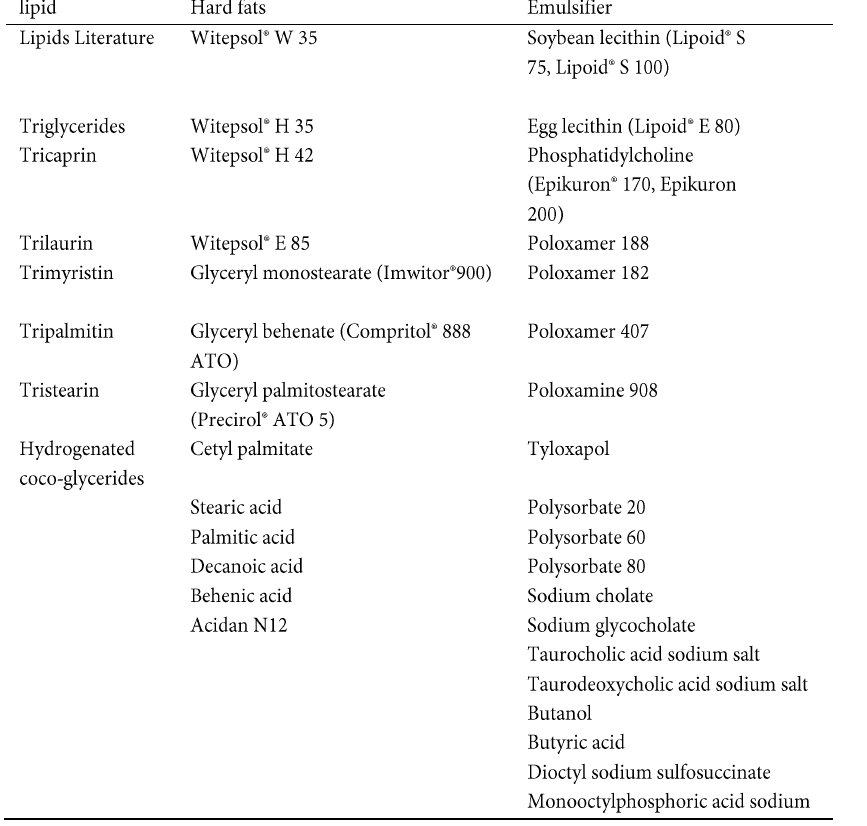
Table 2: Examples of fatty substances and emulsifiers used in SLN